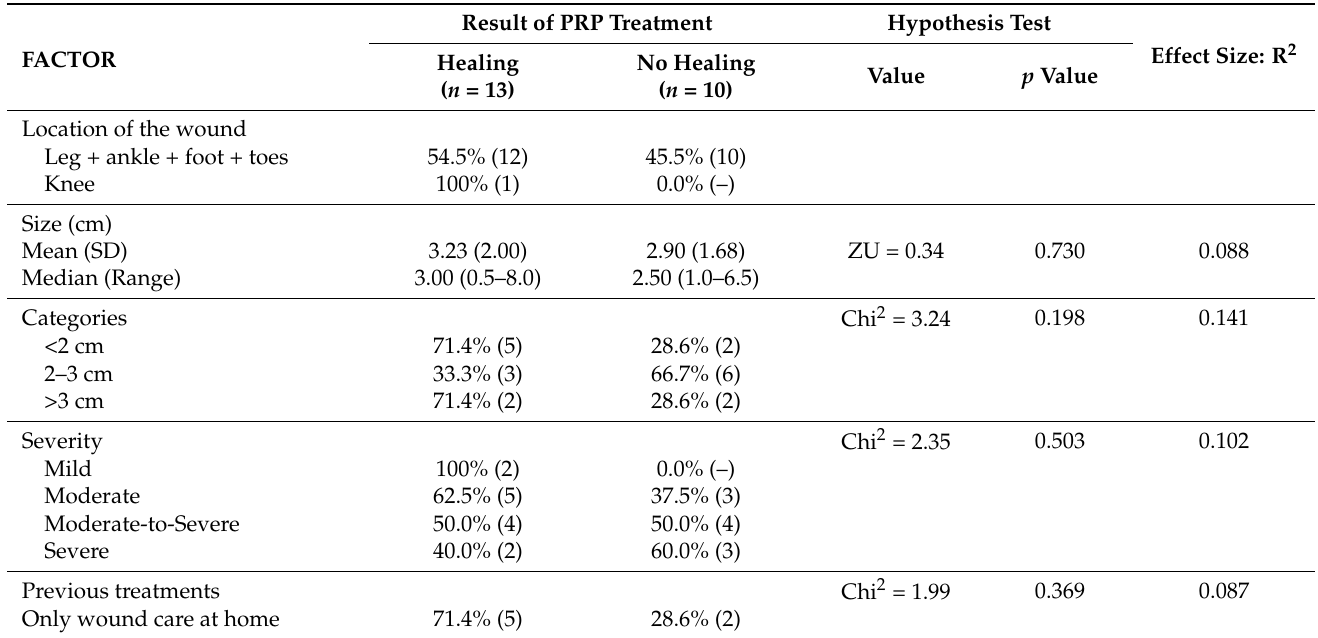
Table 5. Wound-related factors associated with wound healing in patients treated with PRP. ( N = 23 CNHWs).